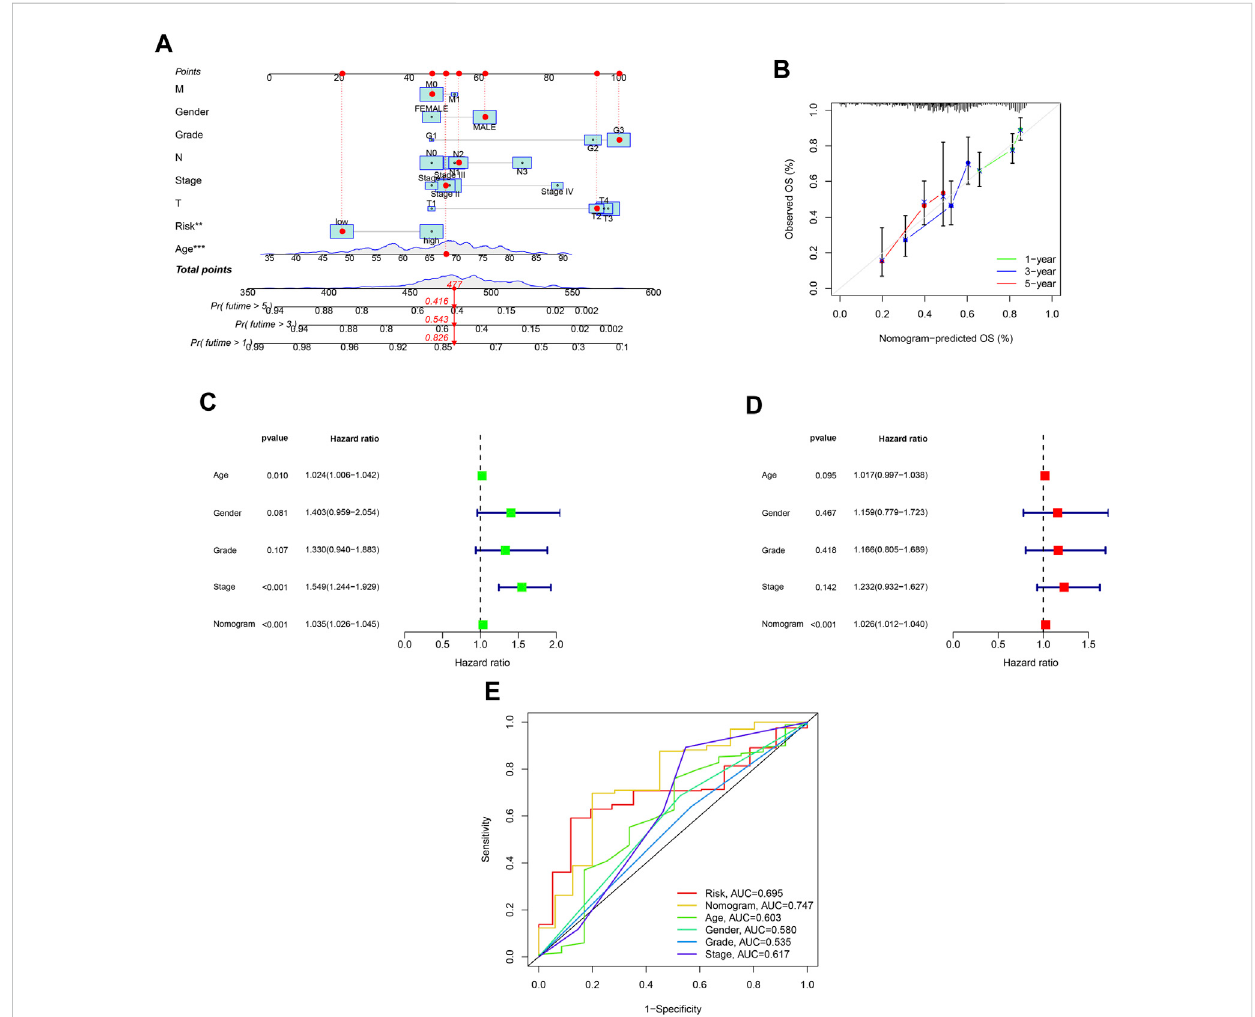
FIGURE 7 EstablishmentofanomogramwithROS-relatedsignatureandclinicalcharacteristics. (A) AnomogramcontainsROS-relatedsignature,age,gender, tumor grade, clinical and T, N and M stage. (B) A calibration plot for assessing the predictive power of nomograms at 1-, 3-, and 5-year. (C) Univariable analysis of the nomogram across TCGA dataset. (D) Multivariable analysis across TCGA dataset. (E) DCA analysis of the nomogram